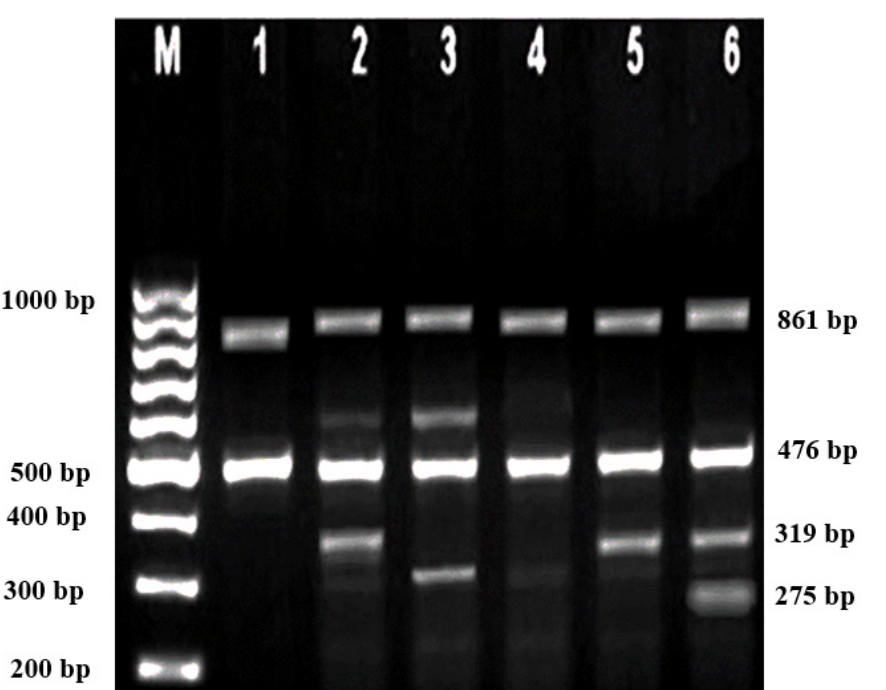
Figure 1. 2% Agarose gel for MARMS A-PCR M is a 100 bp marker; lane 1 is a positive control for 861 bp common A primer; Lane 2 is a positive control for triplicate mutation Cd 41/42 (-TTCT), IVS 1-5 (G>C), and Cd 26 (G>A); Lane 3 and Lane 4 are positive for compound heterozygous Cd 41/42 (-TTCT) and IVS 1-5 (G>C); Lane 5 and 6 are positive for compound heterozygous Cd 41/42 (-TTCT) and Cd 26 (G>A); Lane 7 and 8 are positive for compound heterozygous IVS 1-5 (G>C) and Cd 26 (G>A).